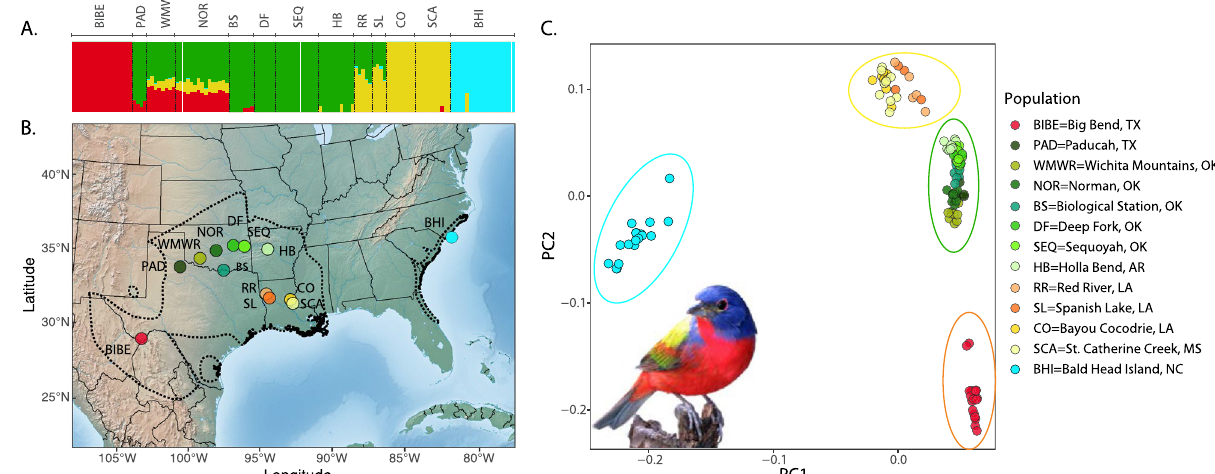
Figure 1. The breeding range of Painted Buntings used for this study, and the genetic clustering of sampled individuals. ( A ) The sampled individuals represent four distinct genetic clusters (Texas: red, Central: green, Louisiana: orange/yellow, and Coastal clusters: cyan). ( B ) Breeding individuals were sampled from 13 locations spanning the entire breeding range of Painted Buntings (dotted line). ( C ) PCA of genetic variation of 41,786 variants. Green dots correspond to the Central genetic cluster and our sampling transect across populations with differences in molting behavior. Painted Bunting photo credit: https:// commo ns. wikim edia.